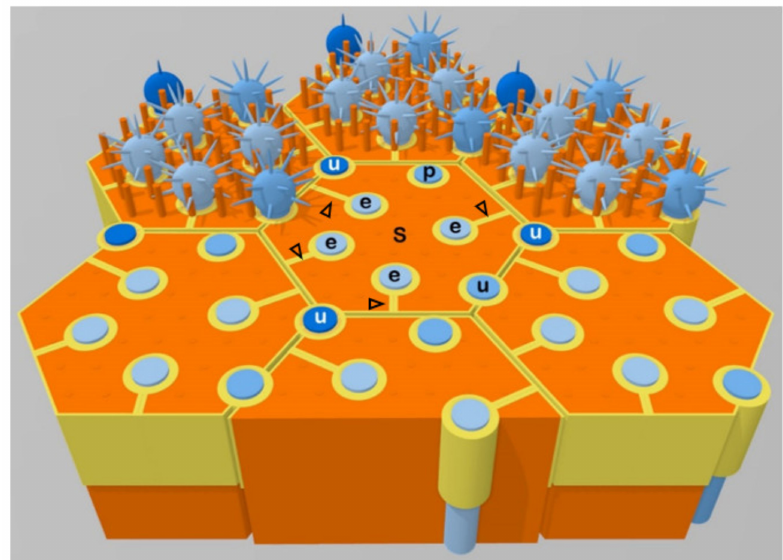
Figure 3. A three-dimensional diagram to show the rat olfactory epithelium (OE) apical layer. Six and a half OSCs (S, orange) and related ORN dendrites are shown, three with intact OSC microvilli, related dendritic knobs, and cilia (top row), and the rest having the OSC microvilli and related dendritic knobs removed to better illustrate relations among the cells. Newly emerged ORN dendrites are immature (highly immunoreactive for class-III β -tubulin) and located at the borderlines between OSC apices (unwrapped, three of them being labeled by “u” in white). Along the course of further maturation (as marked by progressively weakening class-III β -tubulin immunoreactivity), most of the dendrites undergo sideways migration and become enwrapped (“e”) by OSCs, but a few remain unwrapped upon maturity (one being labeled by ‘u’ in black). Partially-wrapped ORN dendrites (one labeled by “p”) may represent intermediate stages from unwrapped immature to enwrapped mature status. The apical junctional complex (yellow) can be distinguished into those homotypic cell–cell junctions between OSCs, heterotypic junctions between OSCs and ORN dendrites, and autotypic junctions that link neighboring pleats or folds of the same OSC, and form the mesenteries of enwrapped dendrites (mesodendrites, arrowheads). Modified with permits from